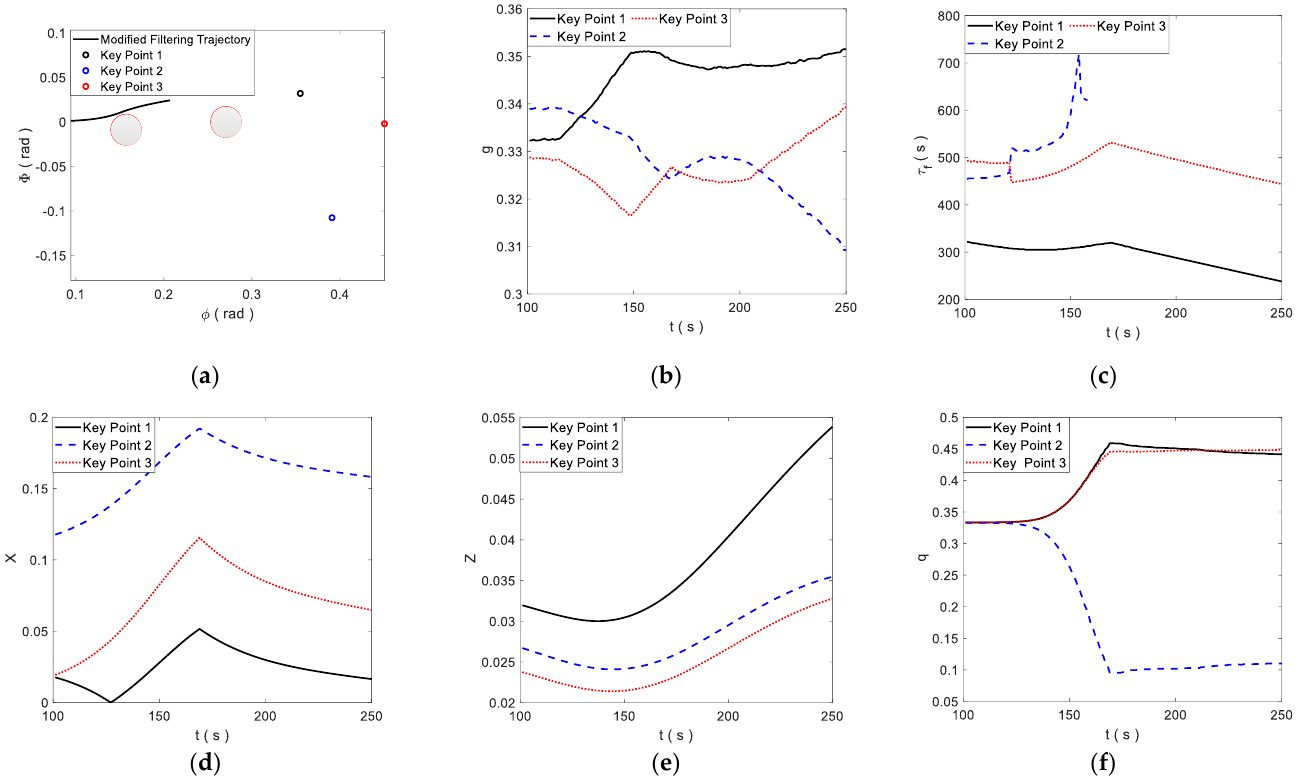
Figure 14. Effect of intention inference network: (a) represent the modified filtering trajectories; (b) is the variation of threat value; (c) is the variation of time-to-go; (d) is the variation of cross-range; (e) is the variation of longitudinal range; (f) is the variation of importance.